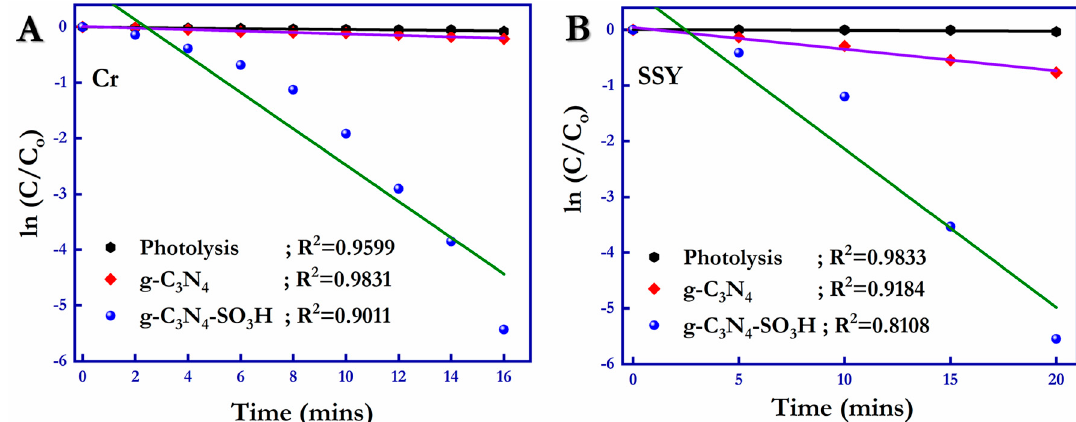
Figure 11. ln (C/C o ) vs. the degradation time fitted with pseudo-first-order kinetics for the photore- duction of Cr(VI) ( A ) and photooxidation of SSY FCF ( B